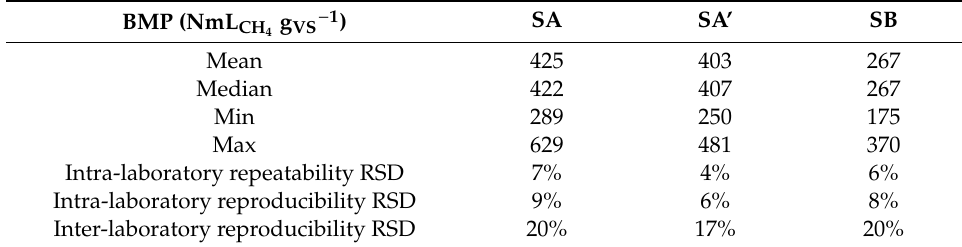
Table 6. Synthesis for the first phase of the French inter-laboratory